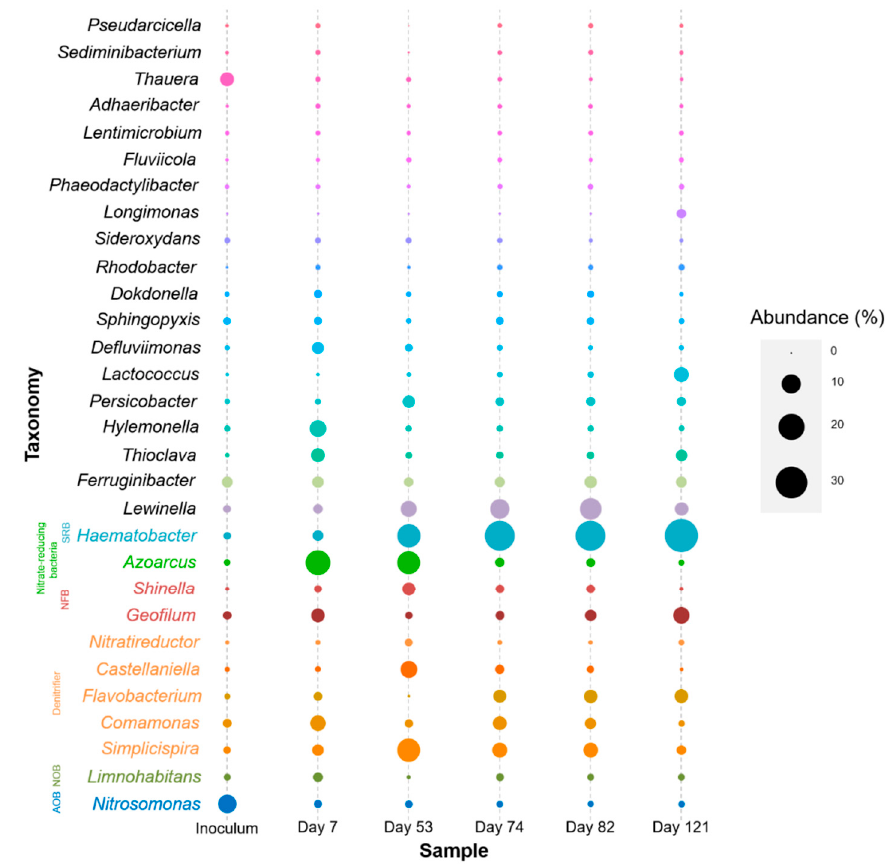
Figure 3. Microbial communities at various conditions at the genus level. The size of bubbles represents the abundance of genera. The colors of generic names represent their functional groups.